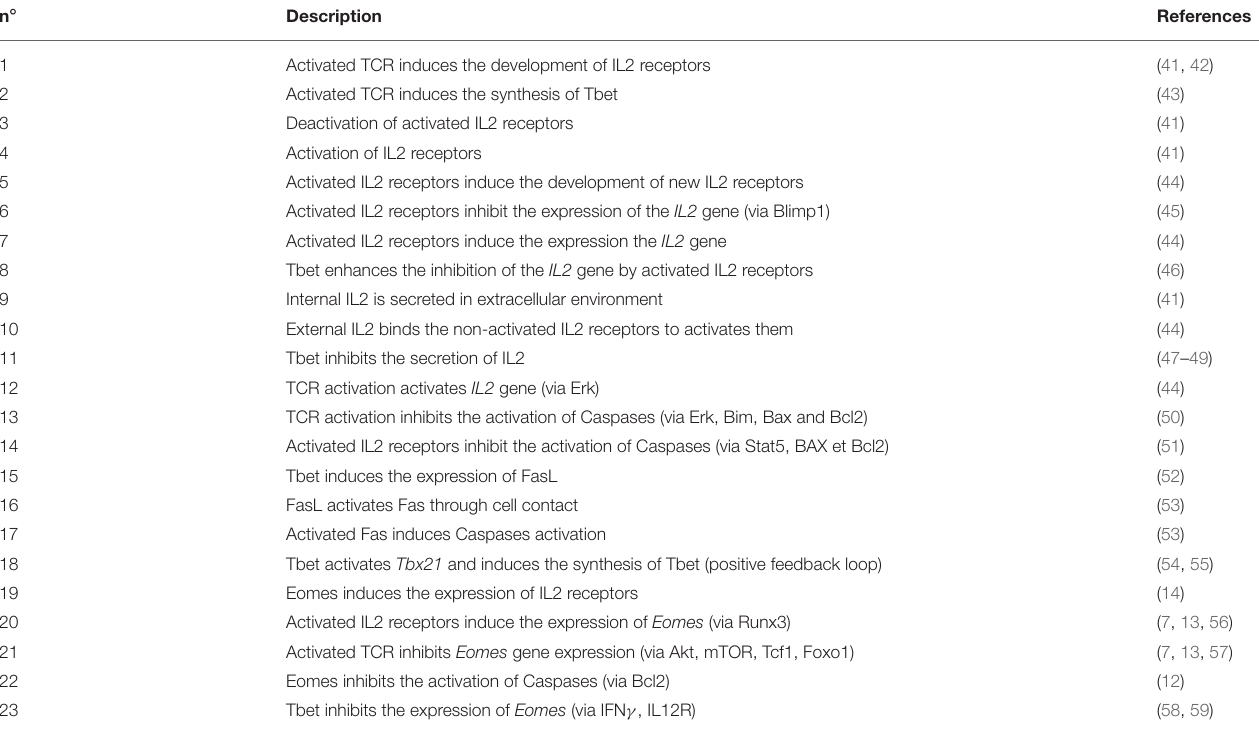
TABLE 1 | Description of the molecular signalling pathways in Figure 1 and corresponding bibliographic references. n ◦